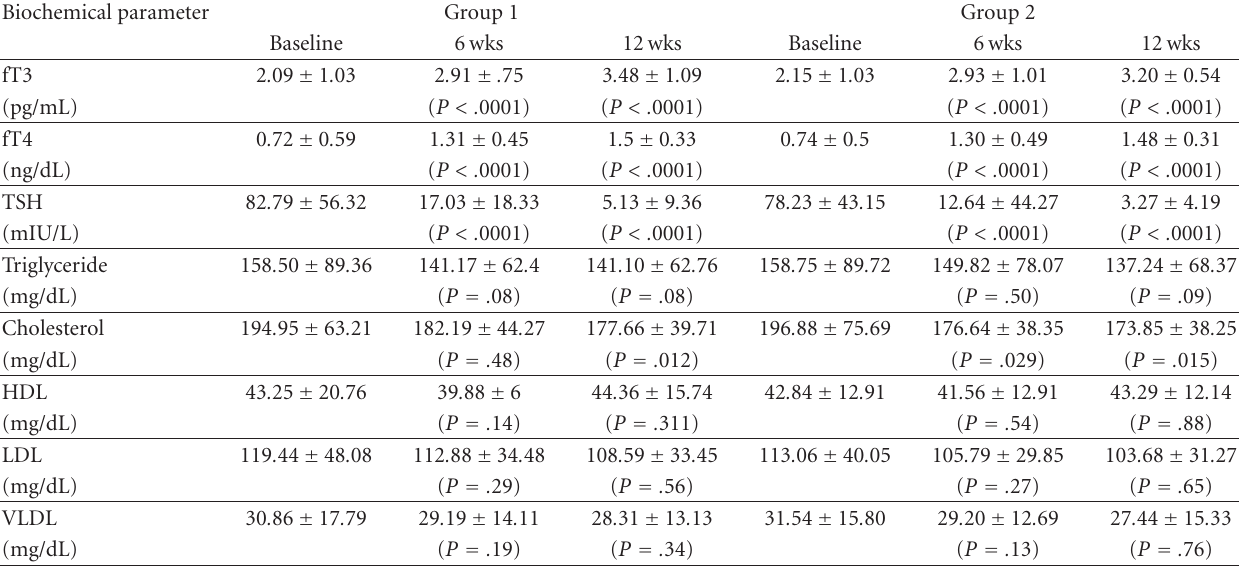
Table 1: Comparison of biochemical parameters (data expressed as mean ± SD) of Group 1 and Group 2 at the end of 6 and 12